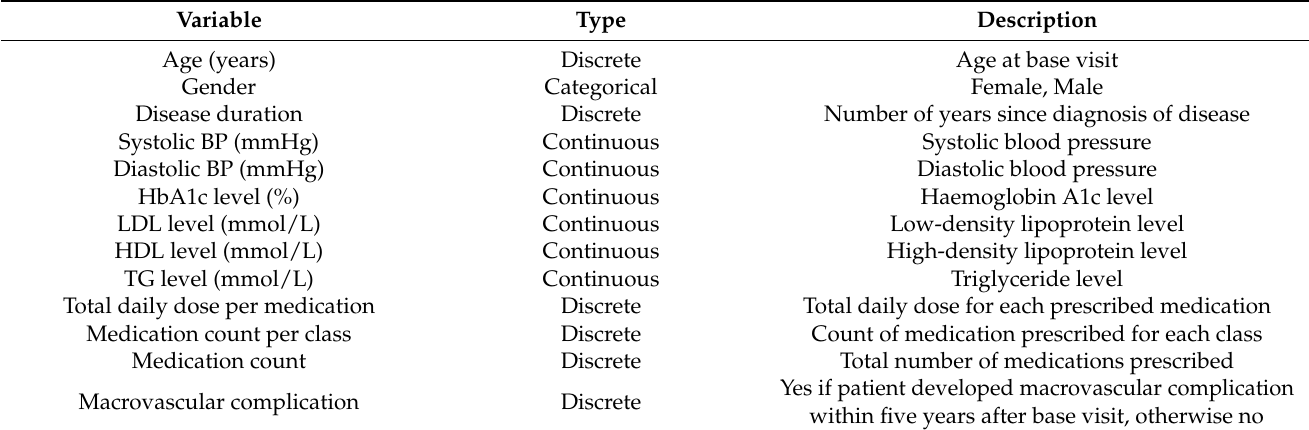
Table 3. List of variables of